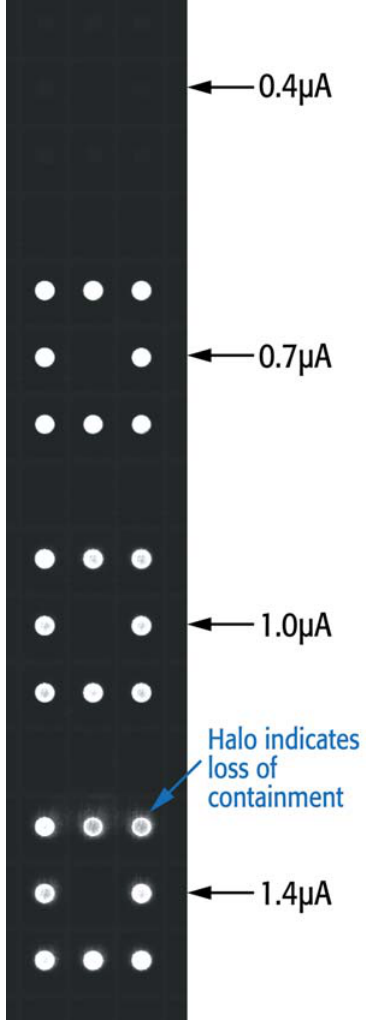
Figure 3. Example of a portion of an array with a box pattern of electrodes used for deprotection and synthesis at 0.4, 0.7, 1.0 and 1.4 micro amp/electrode.